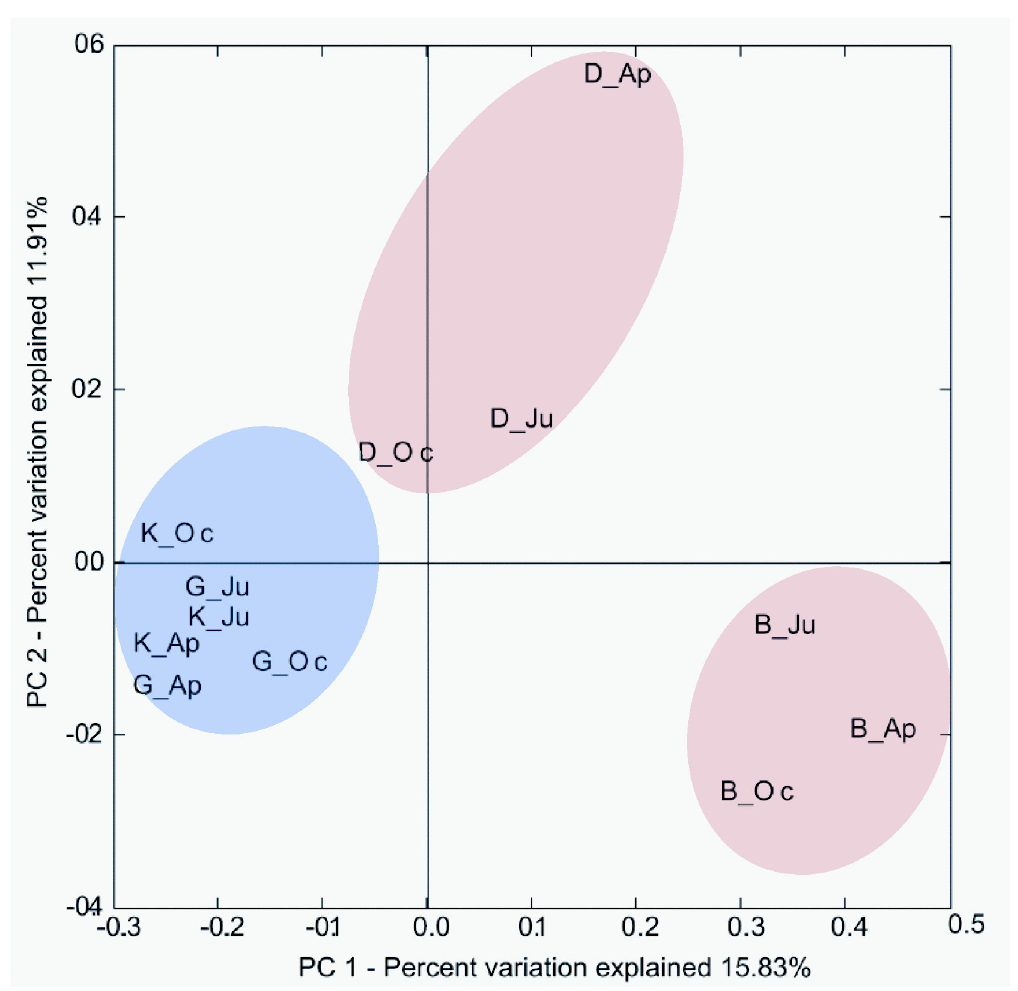
Figure 4. Unifrac analysis of nif H-gene libraries. PCoA of nif H-gene sequences using 1921 randomly chosen sequences per sample, from normalized weighted